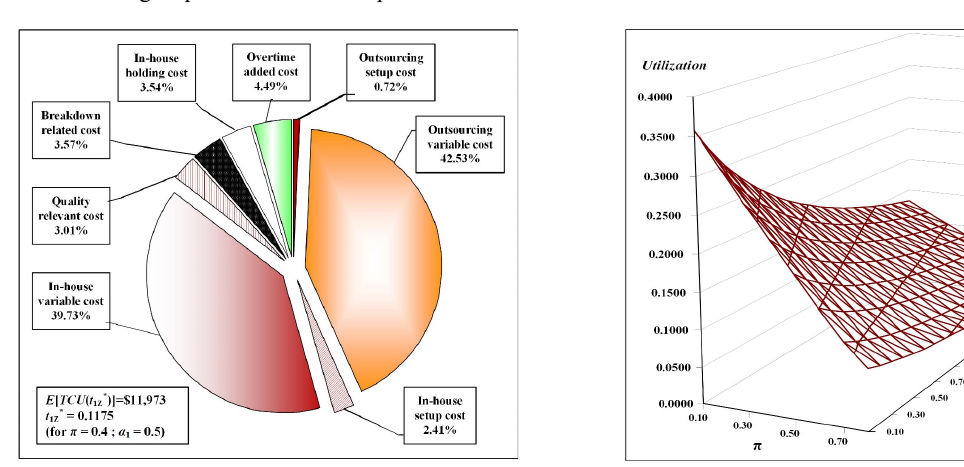
Fig. 11. The detailed cost contributors to E [ TCU ( t 1Z *)] Fig. 12. The combined impact of π and α 1 on utilization